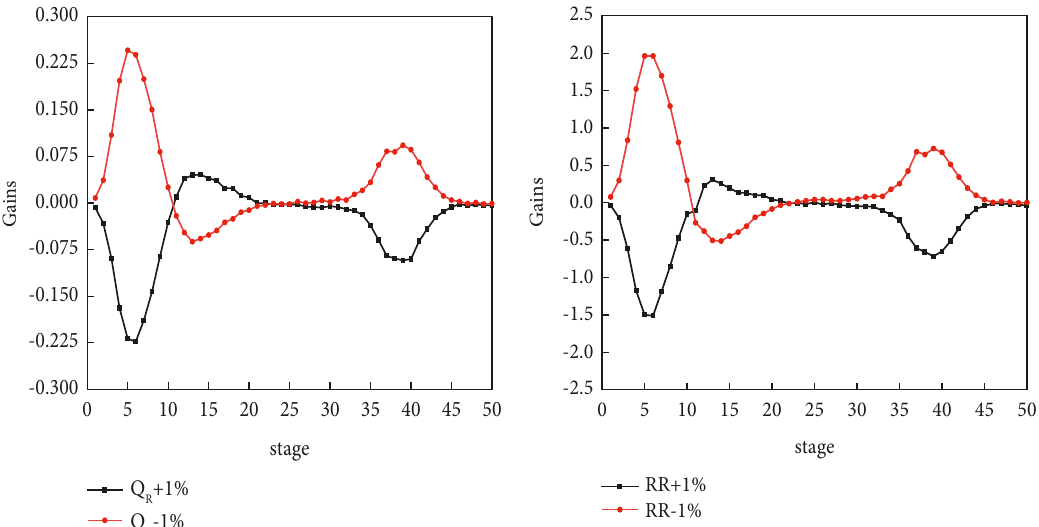
Figure 2: Sensitivity analysis of the main column.